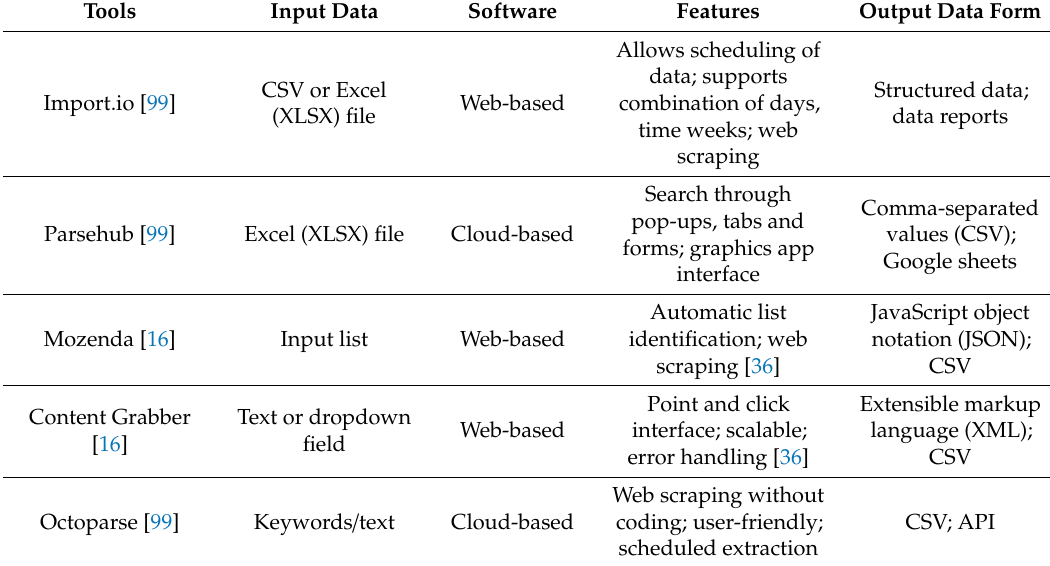
Table 9. Comparison of data filtering